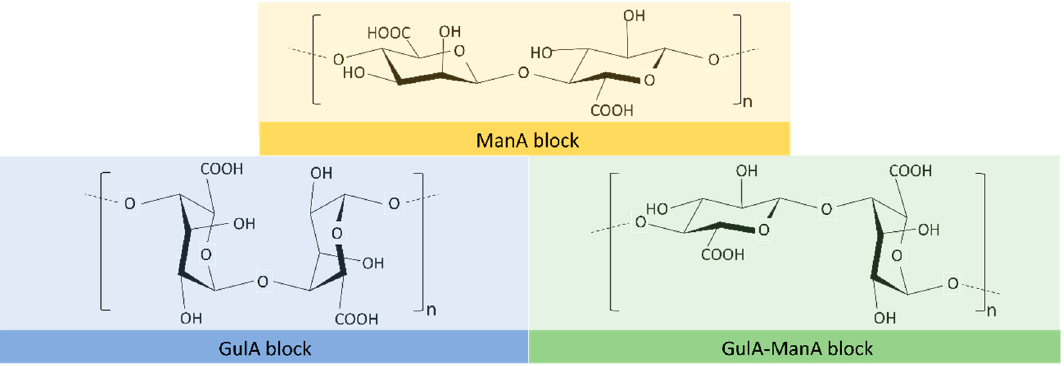
Figure 2. Chemical structure of the different blocks that can be found in